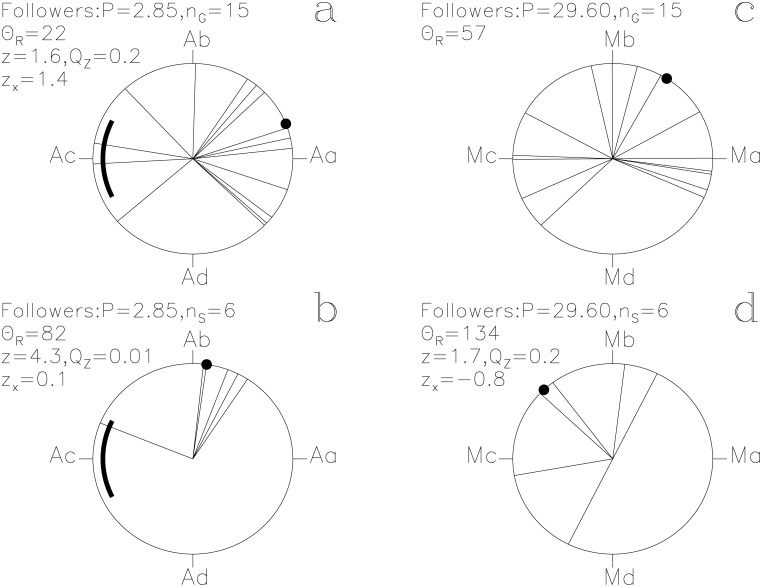
Followers.otherwise as in Fig 1